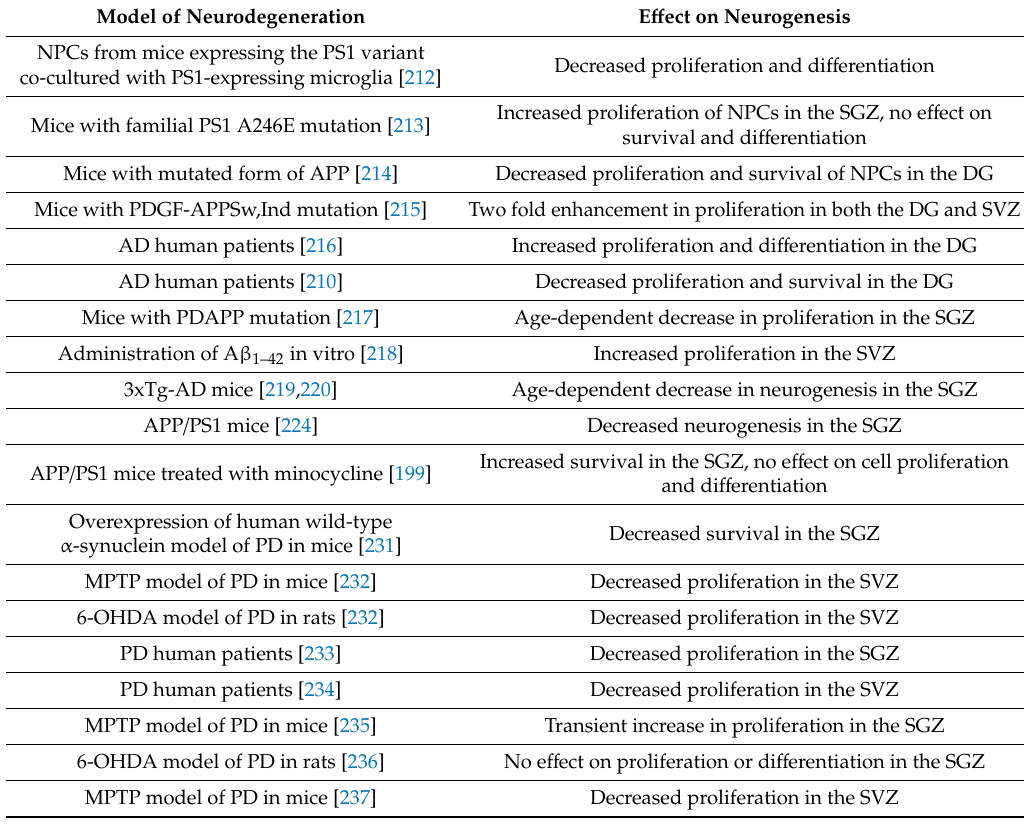
Table 1. Summaryof modelsofneurodegenerationand thereportedeffects onneurogenesis (NPC:neural precursor cell; PS1: presinilin-1; SGZ: subgranular zone; SVZ: subventricular zone; DG: dentate gyrus; AD: Alzheimer’s Disease; PD: Parkinson’s Disease; 6-OHDA: 6-hydroxydopamine;